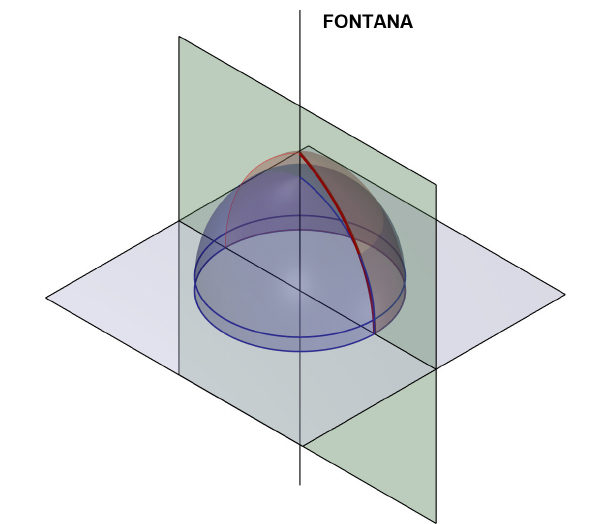
Figure 12. Napoli, S. Maria di Costantinopoli Church: overlap to Fontana model